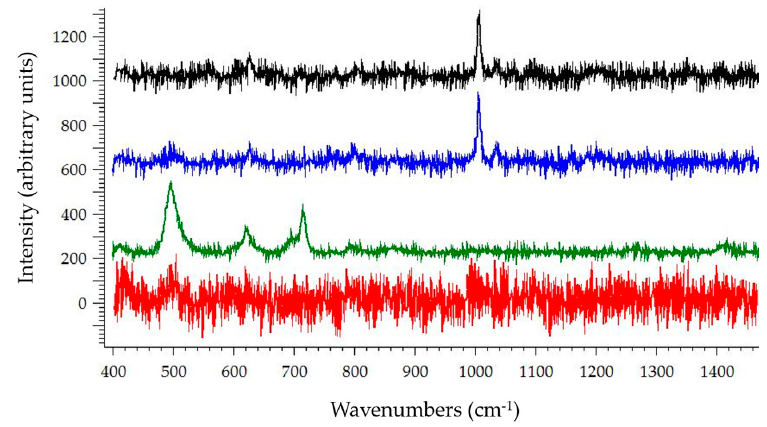
Figure 5. Raman spectra of 3.3 μ m PSS trapped within the cDEP device (black), PSS on quartz coverslip (blue), PDMS (green), and the quartz coverslip with 0.005× PBS (red). The spectrum of PSS on a quartz coverslip (blue) is the positive control. The spectra of PDMS (green) and the quartz coverslip without PSS (red) are negative controls.